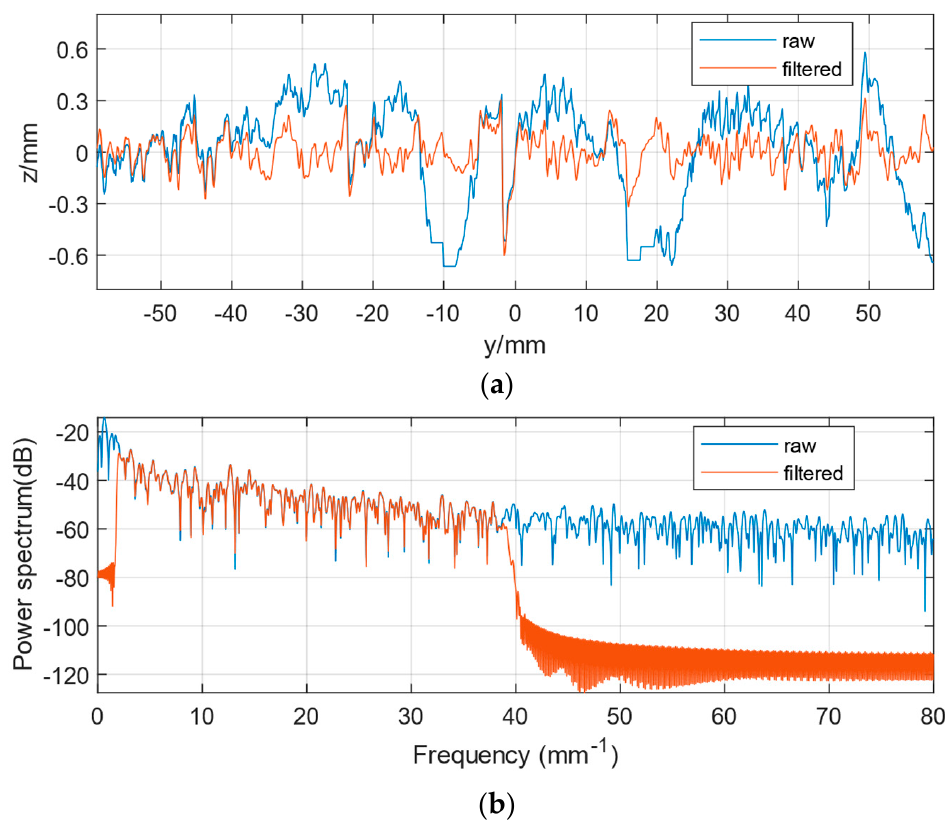
Figure 8. Micro-texture filtering results. ( a ) Band-pass filtering of texture (Fpass = [2 38.46] mm − 1 ). ( b ) Power spectrum of bandpass filtered texture.